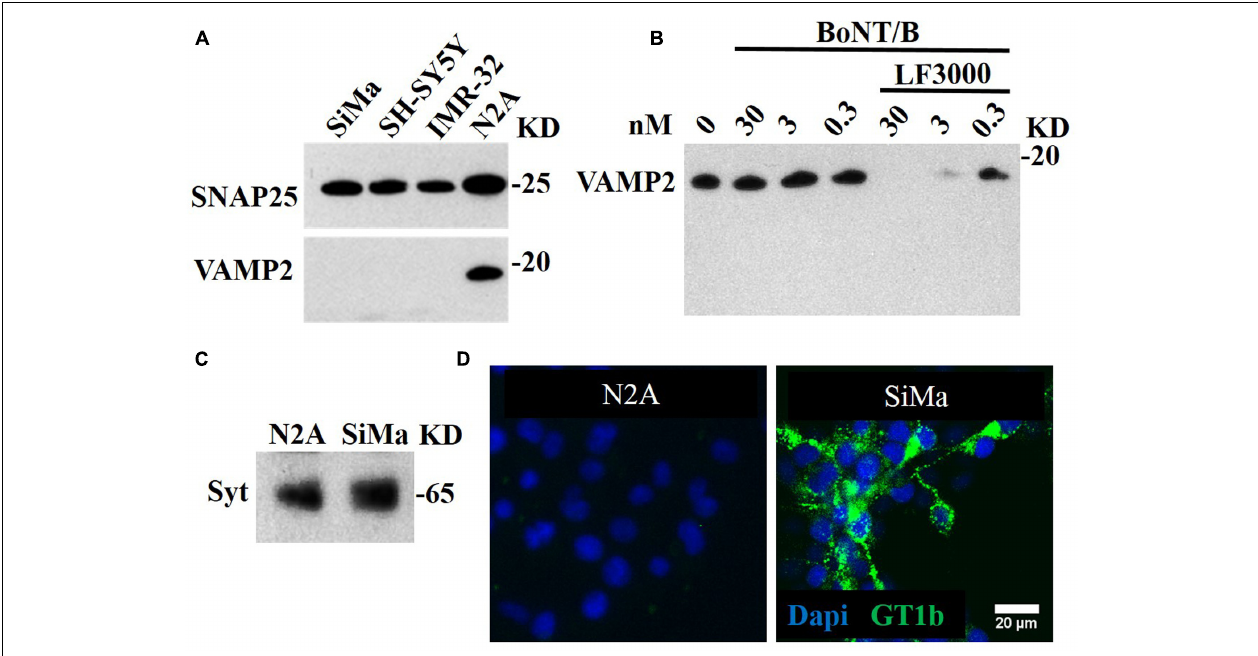
FIGURE 1 | BoNT/A-sensitive SiMa neuroblastoma cell line expresses neuronal gangliosides and synaptotagmin but not BoNT/B substrate VAMP2. (A) Three neuroblastoma cells (SiMa, SH-SY5Y and IMR-32) express the BoNT/A substrate SNAP25 but not the BoNT/B target VAMP2. Only the N2A neuroblastoma cell line expresses both SNAP25 and VAMP2. (B) BoNT/B does not cleave VAMP2 in N2A cells at indicated concentrations. Transduction of BoNT/B into N2A cells using Lipofectamine LF3000 (LF3000) allows VAMP2 cleavage. Note the absence of VAMP fragments at all BoNT/B concentrations. (C) A polyclonal antibody against synaptotagmin 1 reveals its presence in the SiMa and N2A cell lines. (D) The SiMa but not N2A cell line expresses neuronal ganglioside GT1b as revealed by specific anti-GT1b antibody.